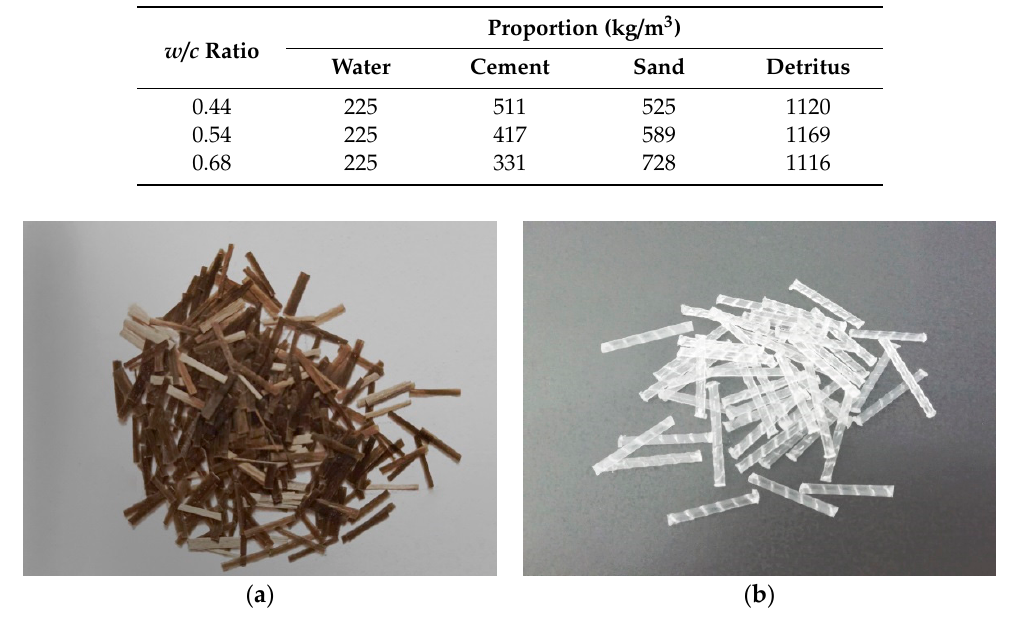
Figure 2. Basalt fiber and macro synthetic fiber: ( a ) basalt fiber (BF); ( b ) macro synthetic polypropylene fiber (SF).